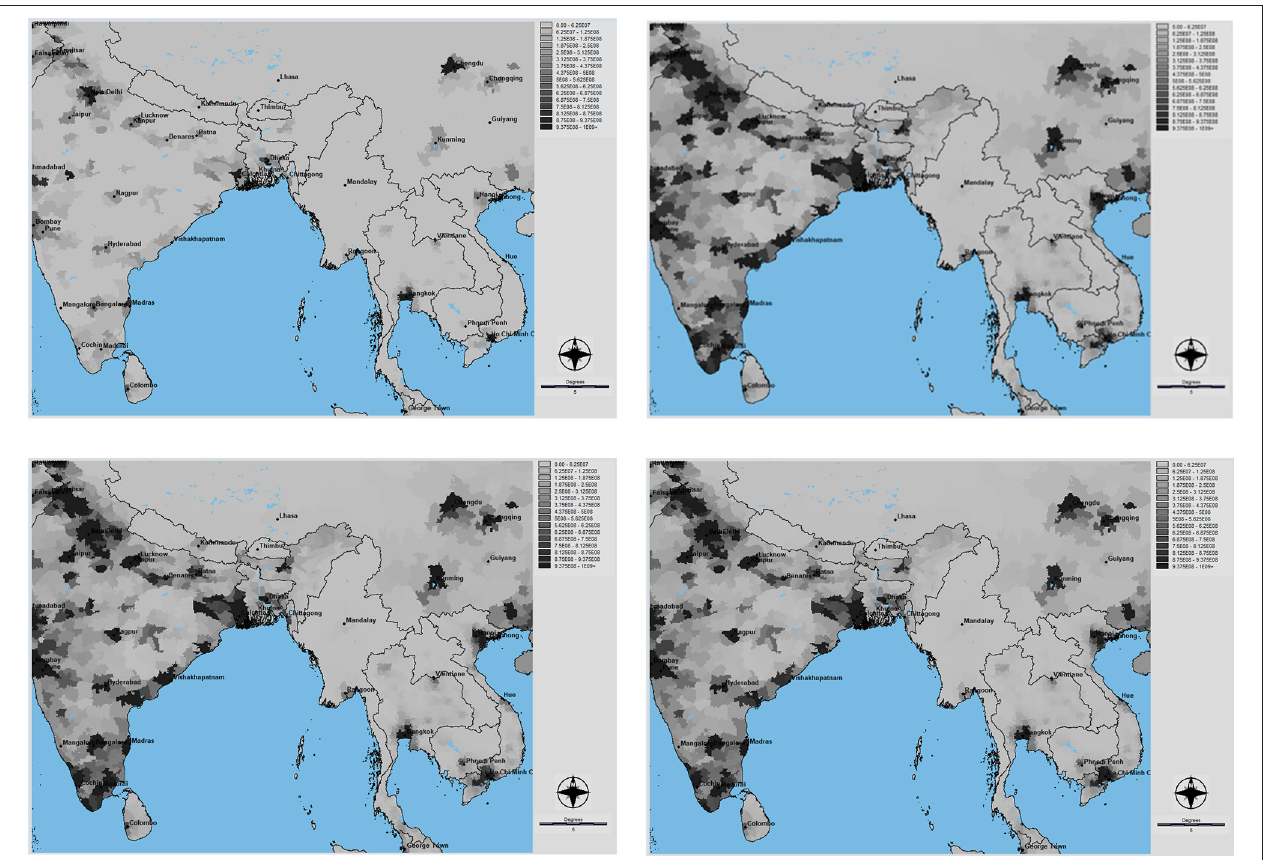
FIGURE 4 | Current GDP (top left) and projected GDP per administrative units (FAO GAUL2) in US$ per pixel ( ∼ 80 km 2 ): SSP1 (top right) SSP2 (lower left) and SSP3 (lower